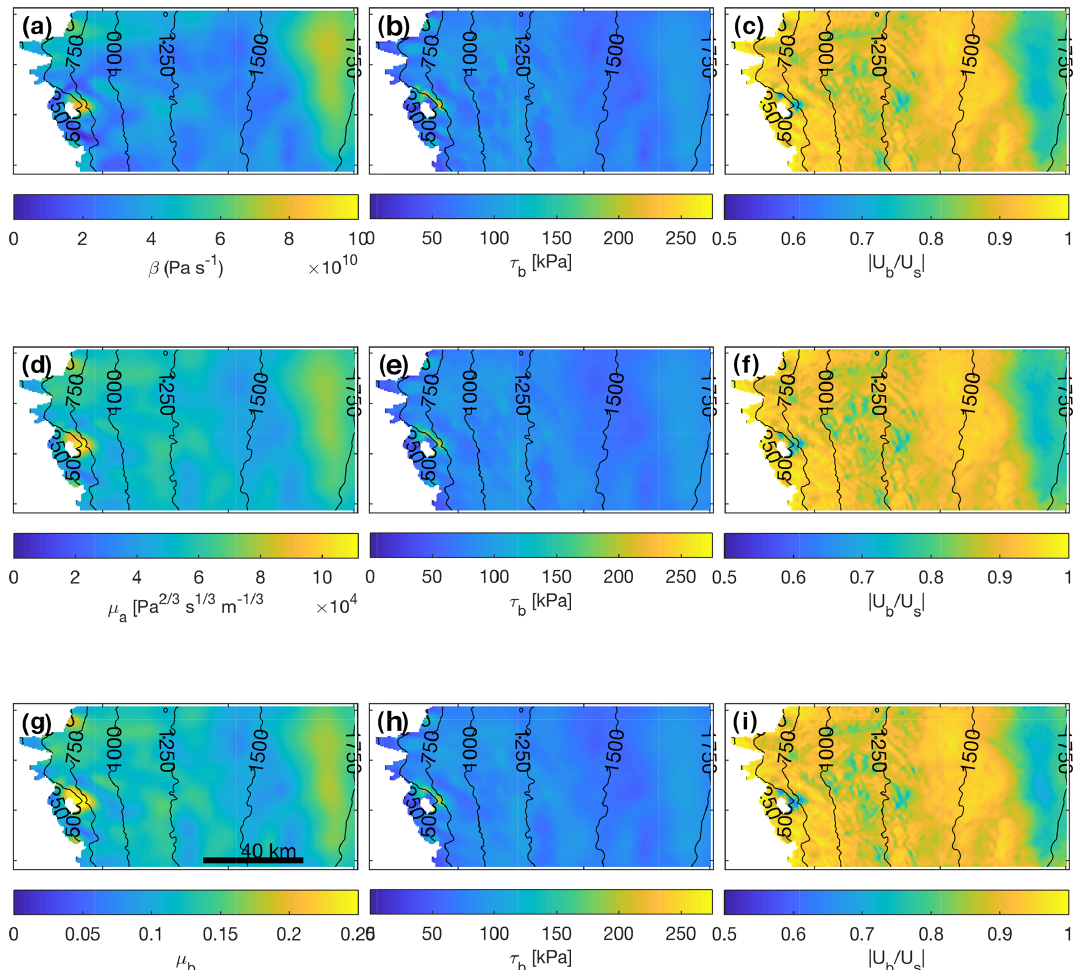
Figure 5. Inversion results for the three sliding laws. Subplots (a–c) relate to the Linear sliding law, (d–f) relate to the Budd sliding Law, and (g–i) relate to the Schoof sliding law. Panels (a) , (d) , and (g) show the inverted drag parameter. Panels (b) , (e) , and (h) show basal drag. Panels (c) , (f) , and (i) show the sliding